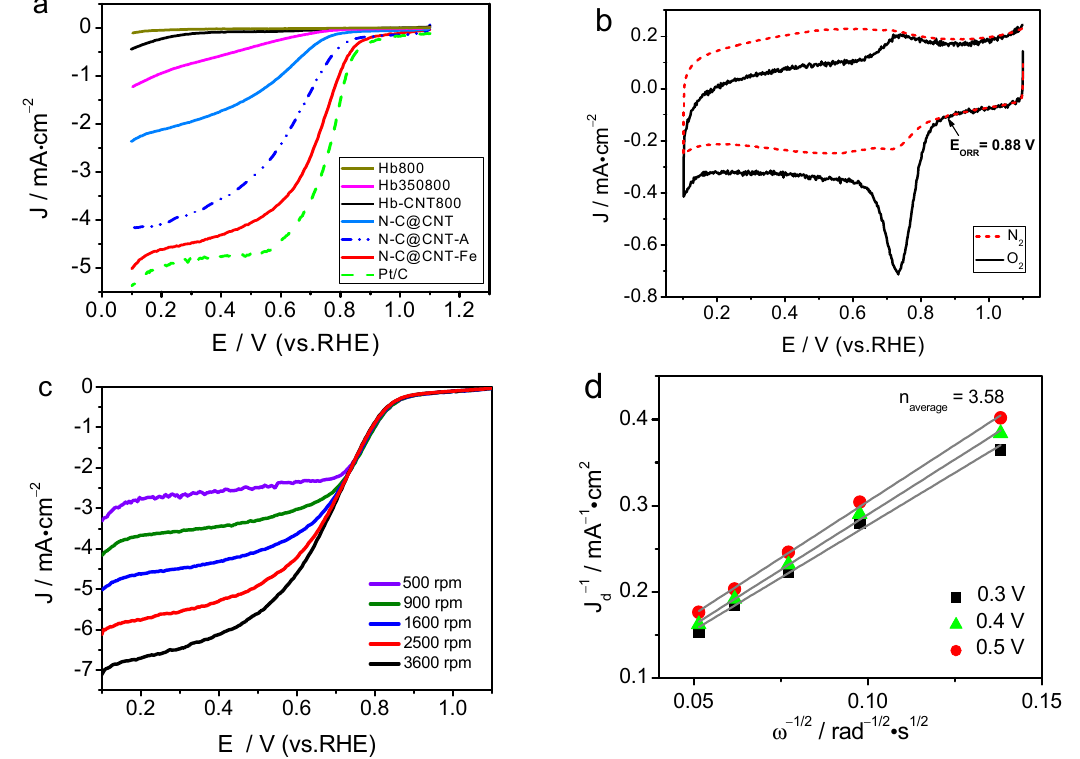
Figure 4. ( a ) Linear sweep voltammetry curves of Hb800, Hb350800, Hb-CNT800, N-C@CNT, N-C@CNT-Fe, N-C@CNT-A, and 20 wt.% Pt/C in O 2 -saturated 0.1 mol·L − 1 HClO 4 solution at a rotation rate of 1600 rpm; ( b ) Cyclic voltammetry curve for oxygen reduction reaction (ORR) of N-C@CNT-Fe in O 2 or N 2 -saturated 0.1 mol·L − 1 HClO 4 solution; ( c ) LSV curve for ORR of N-C@CNT-Fe in 0.1 mol·L − 1 HClO 4 solution at different rotation rates (500–3600 rpm); ( d ) Koutecky–Levich plots of J − 1 vs. ω − 1/2 ; Data were obtained from ( c ).